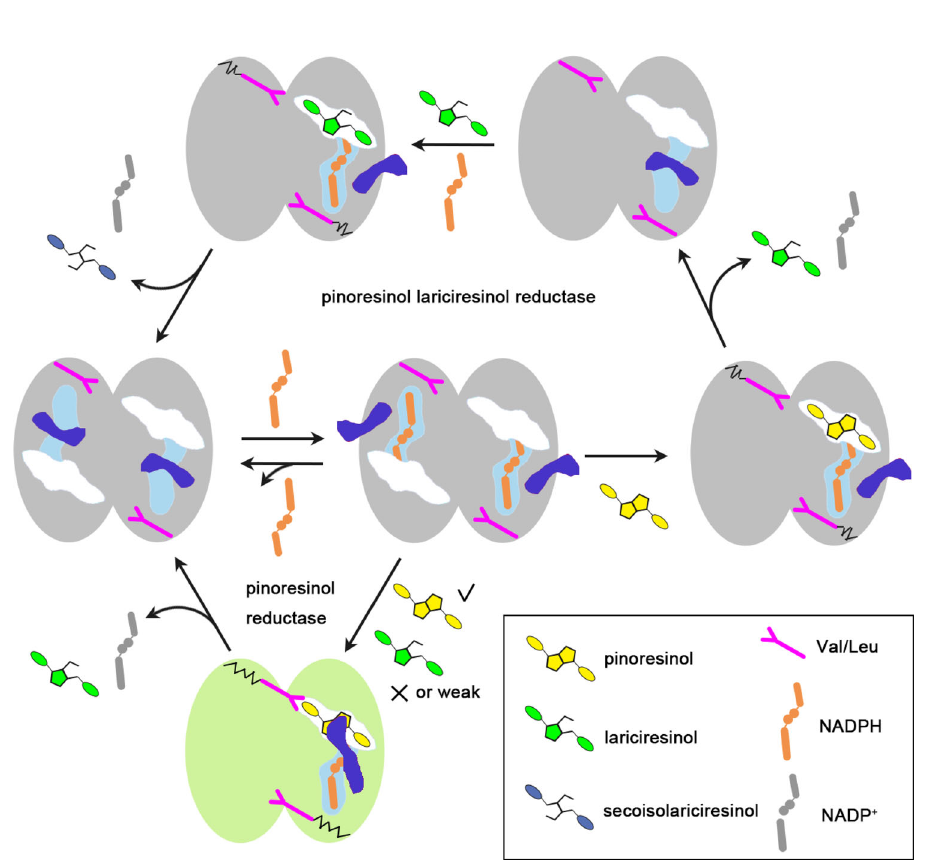
Fig. 5 Model depicting the catalytic processes of PLRs and PrRs. The blue dumbbell-shaped objects represent switches composed of β 4 loops. A movie showing how the enzymes change conformation throughout a single round of catalysis can be found in Supplementary Movie 1.